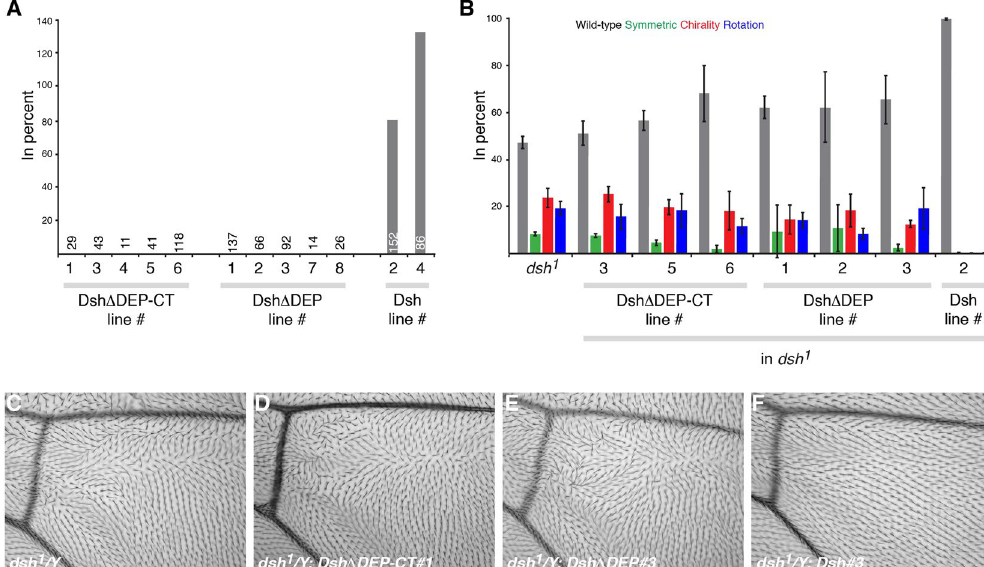
Figure 4. Variants of Dsh lacking the DEP domain and C-terminus (Dsh Δ DEP-CT) or the DEP domain (Dsh Δ DEP) expressed under the endogenous promoter do not rescue canonical Wnt or PCP signaling. ( A ) Relative rescue of lethality of indicated transgenic lines. In contrast to wild-type Dsh, no rescue of the dsh V26 null allele is detected with any of the Dsh variants (five independent transgenic insertions tested for mutant Dsh forms). B–F ) In contrast to wild-type Dsh, none of the Dsh variants is able to rescue the PCP defects of the PCP specific dsh 1 allele in the eye ( B ; wild-type, symmetric ommatidia, chirality and rotation defects were scored) or wing ( C–F show enlargement of wing areas distal to the posterior cross veins). Three independent transgenic lines were assessed for rescue of PCP